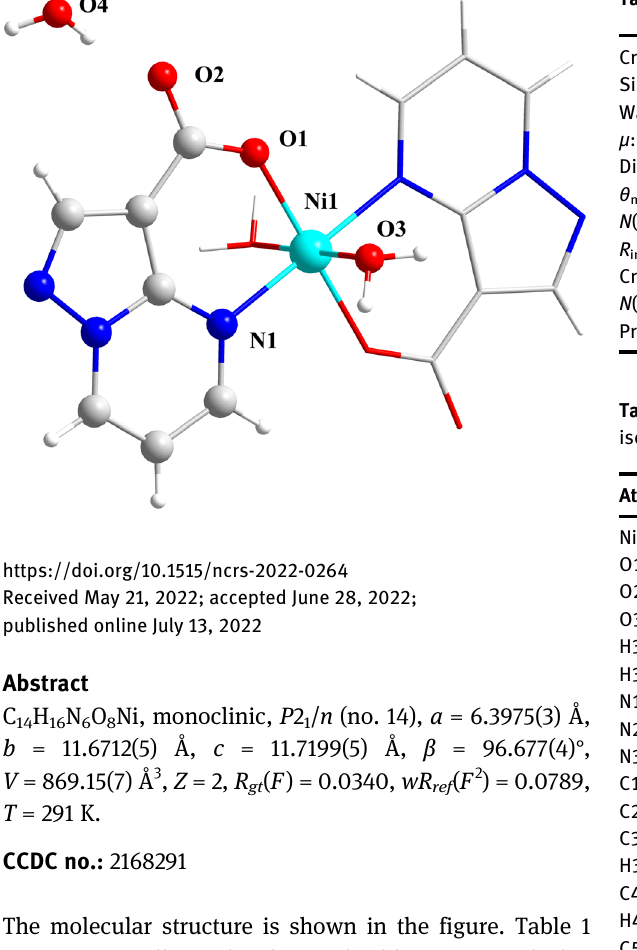
Table  : Data collection and handling.